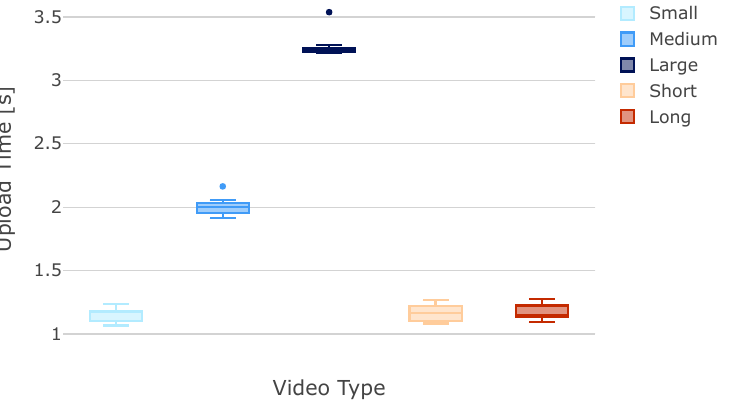
Figure 14. Upload Time Distributions for each video type using the University (UNI) Internet